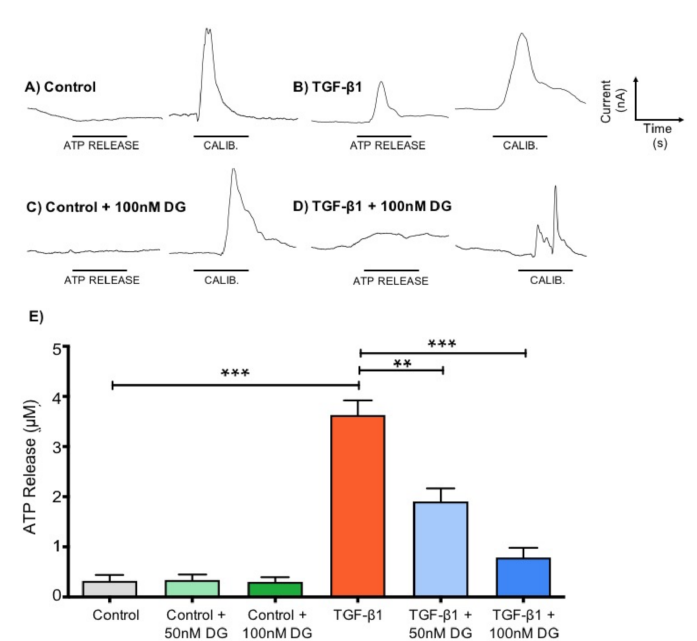
Figure 2. Danegaptide prevents TGF β 1-evoked increases in ATP release. HK2 cells were cultured in low glucose (5 mM) with/without TGF β 1 (10 ng/mL) ± danegaptide (50 or 100 nM) for 48 h. Representative biosensor traces show ATP release following removal of extracellular calcium. Control cells (panel ( A )) exhibit negligible ATP release compared to a calibration (CALIB) response to 10 µ M ATP, whilst a marked increase in release was observed from TGF β 1-treated cells (panel ( B )). Danegaptide (100 nM) alone failed to alter basal ATP (panel ( C )) but significantly reduced TGF β 1- evoked ATP release (panel ( D )). Peak responses were quantified by comparing against a known concentration of ATP (10 µ M) and mean data ± SEM plotted (panel ( E )). Results are representative of 3 separate experiments ( n = 3; ** p < 0.01, *** p < 0.001; one-way ANOVA and Tukey’s